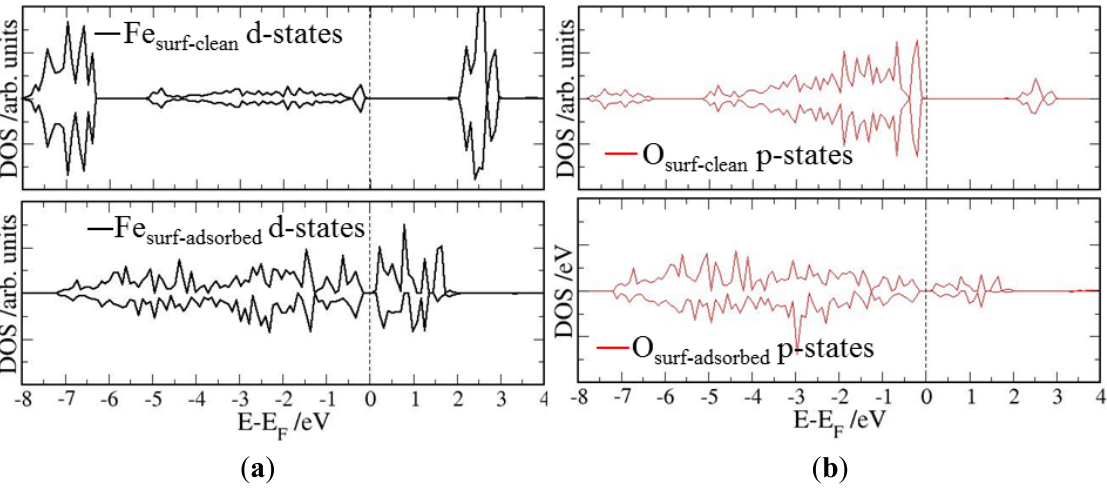
 O (01 1 2). The Fermi level is set to 2 3